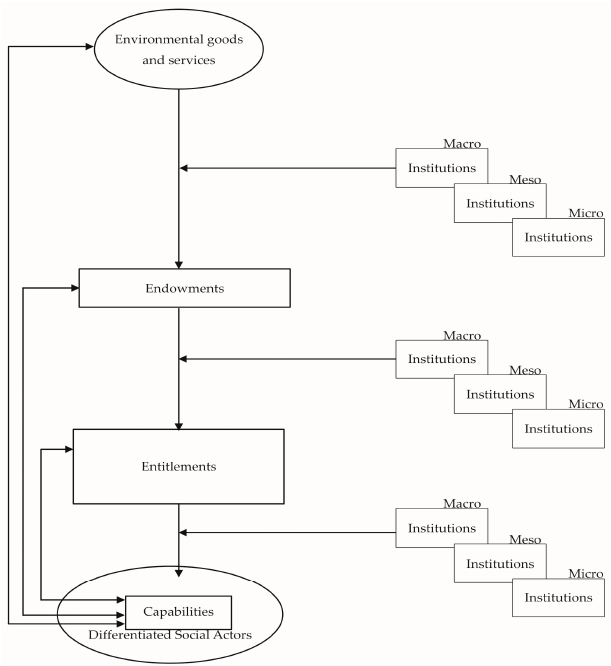
Figure 1. Environmental entitlements mapping: leach et al. [33] reproduced with permission.